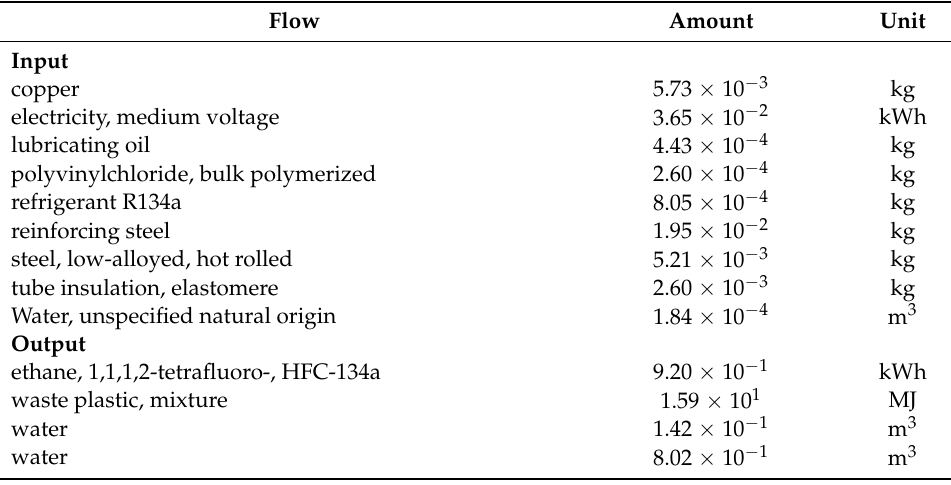
Table A4. Material inventory data for electric heat pump (Case